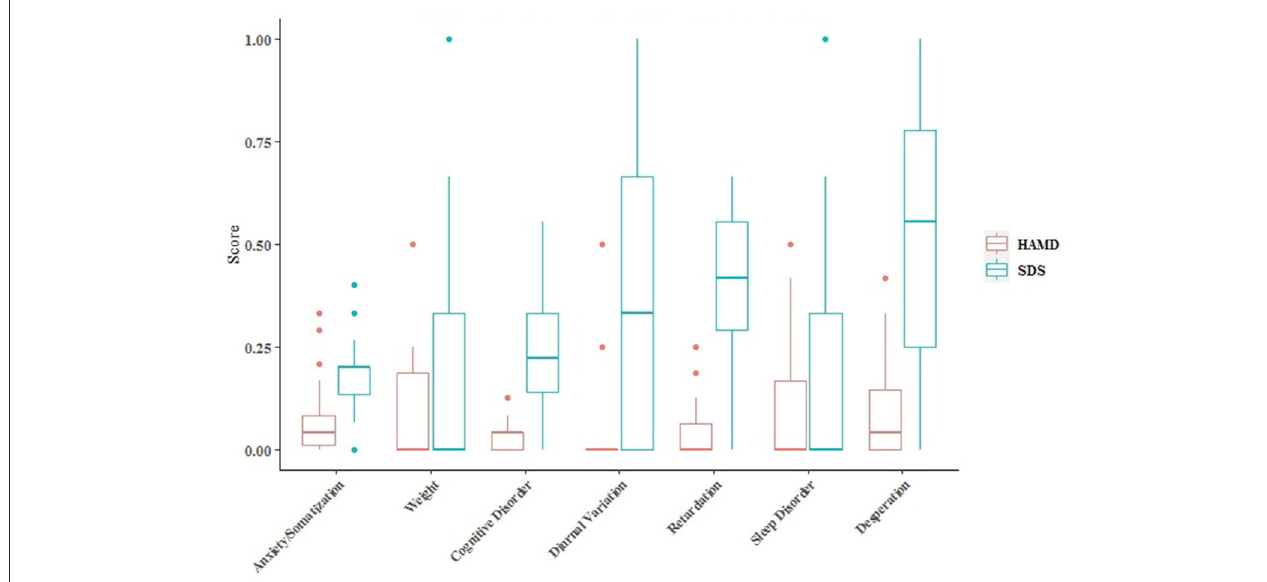
FIGURE 3 | The SDS scale was divided and matched according to the seven dimensions of HAMD, and the scores of the same dimension were compared.